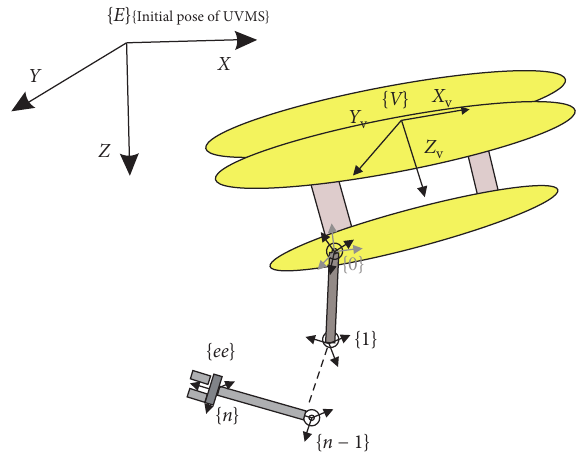
Figure 1: Frames of a